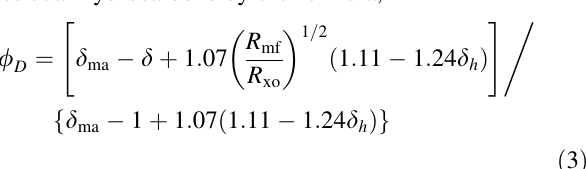
Fig. 10 VCL responses from GR computed by different methods